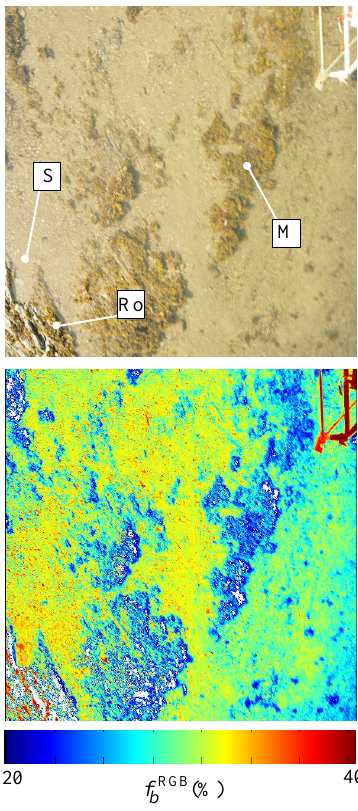
Figure 7. Proportion of bottom-derived radiance over different benthic cover types. M: macroalgae, S: broken shells, Ro: rock As a first-order approximation, the cloud-shadow technique quickly revealed the larger bottom reflectivity of rocks and sediments largely composed by mussel shells ( f bRGB > 40%) with respect benthic communities dominated by macroalgae ( f bRGB